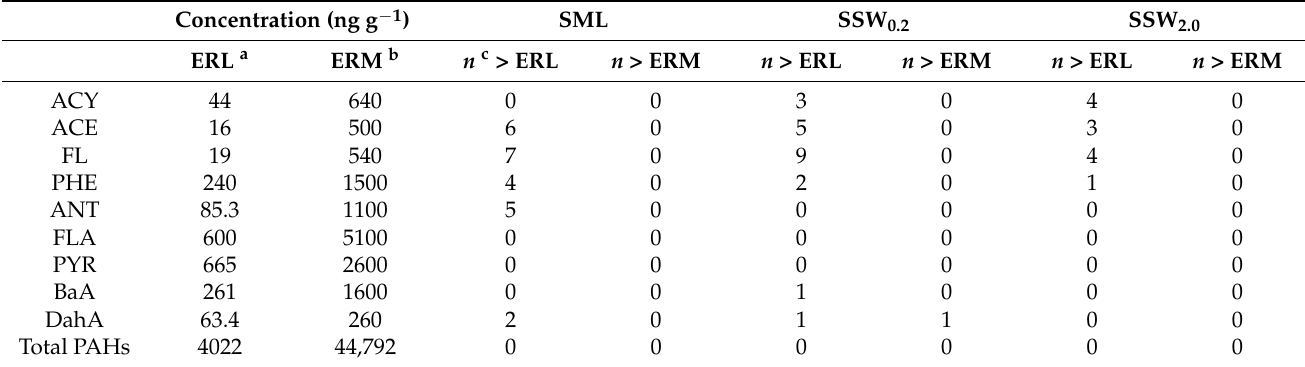
Table 4. Toxicity assessment comparing the individual and total PAHs levels in the particulate phase (ng g − 1 ) of